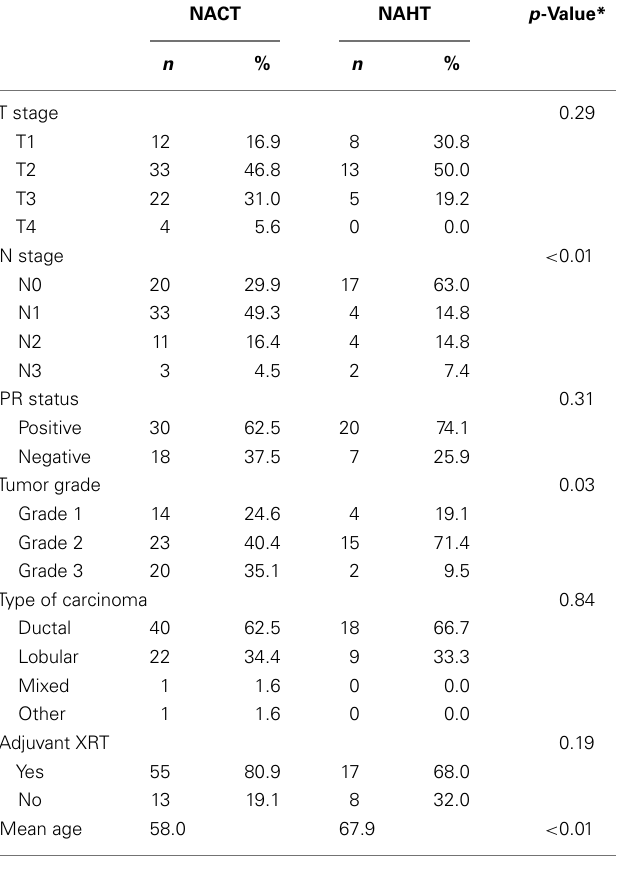
Table 1 | Baseline patient characteristics for all patients receiving either neoadjuvant chemotherapy (NACT) or neoadjuvant hormone therapy (NAHT) prior to surgery for estrogen receptor-positive breast cancer at Emory University between 2004 and 2011 .